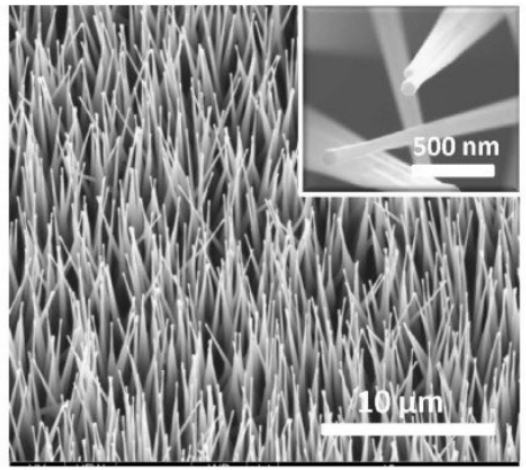
Figure 26. FESEM image (tilted at 15°) of a directly synthesized vertically aligned ZnO nanowire array on a fluorine-doped tin oxide (FTO) substrate. The inset is a higher-magnification image. Reproduced from Lu et al. [306]. Published by Springer as open access.